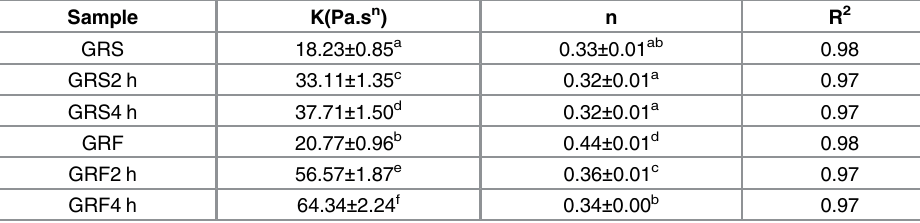
Values expressed are means ± standard deviations (n = 3). Values followed by the same letter in the same column are not signi fi cantly different ( p <